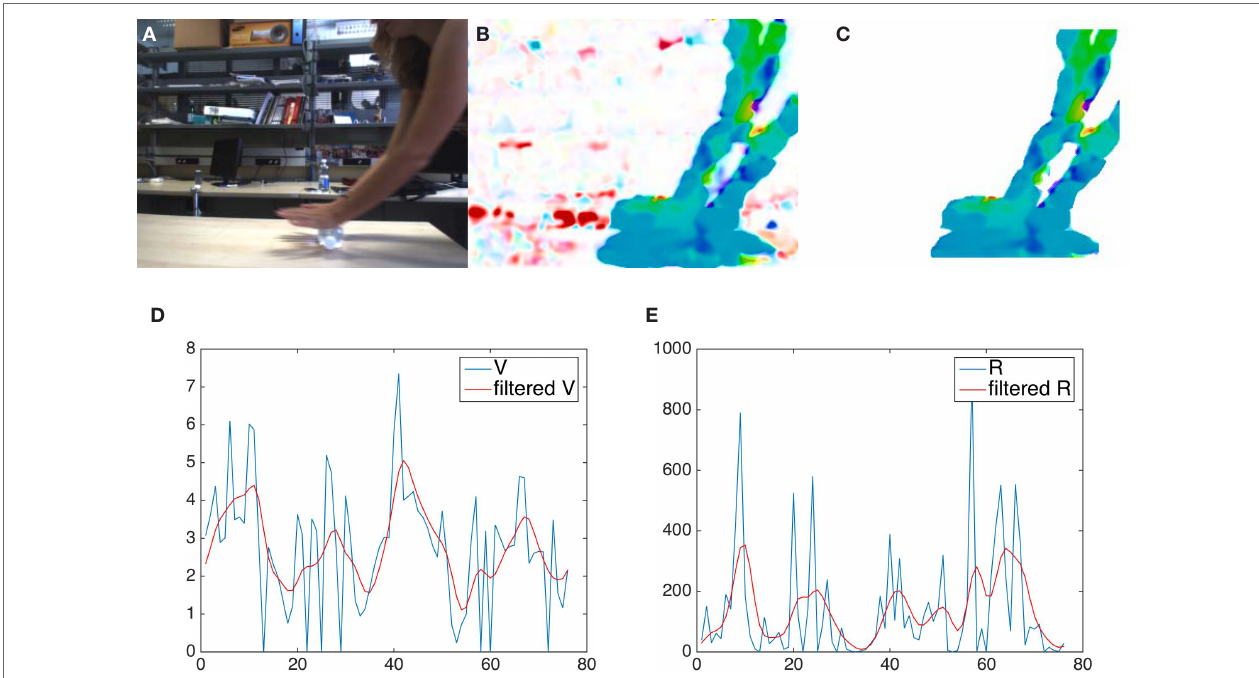
FIGURE 1 | The key steps of our low-level motion representation . First row, from left: (A) the original frame, (B) the map of the optical flow magnitude and (C) the segmented region. Below: a visual comparison between raw (blue) and filtered (red) features; (D) velocity and (E) radius of curvature.